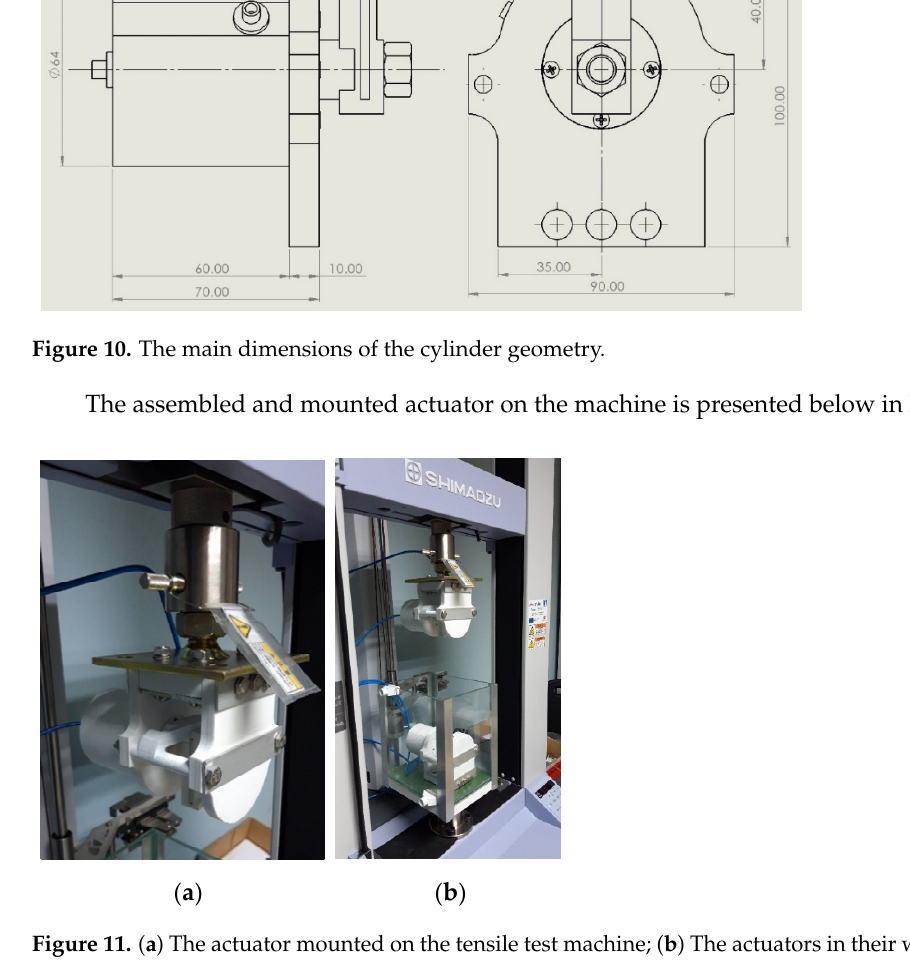
Figure 9. The actuator: ( a ) Front exploded view; ( b ) Back exploded view.